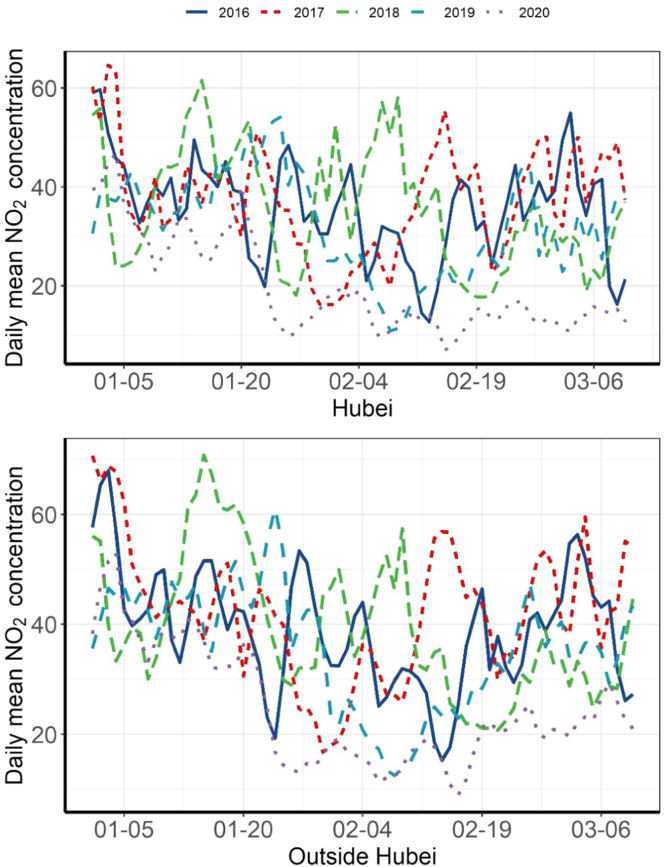
Daily variation of mean NO2 concentration in 2016–2020. The above panel shows the change of the average NO2 concentration of 12 cities in Hubei Province from January 1 to March 10, 2016–2020. The following panel shows the change of the average NO2 concentration of 51 cities in Hubei Province from January 1 to March 10, 2016–2020, in which the lines of different colors represent different annual shares. (For interpretation of the references to color in this figure legend, the reader is referred to the web version of this article.)